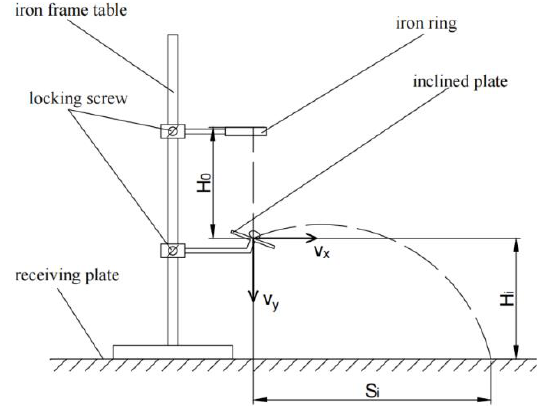
Figure 4. Schematic diagram of inclined plate collision